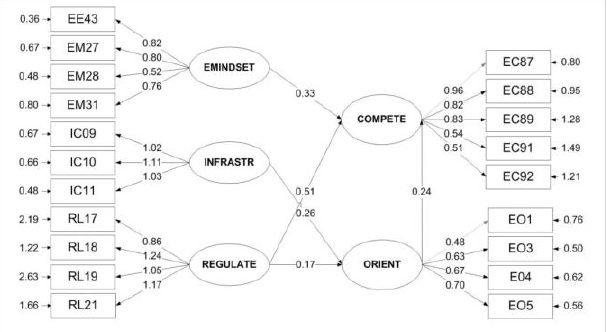
Figure 2: Structural model